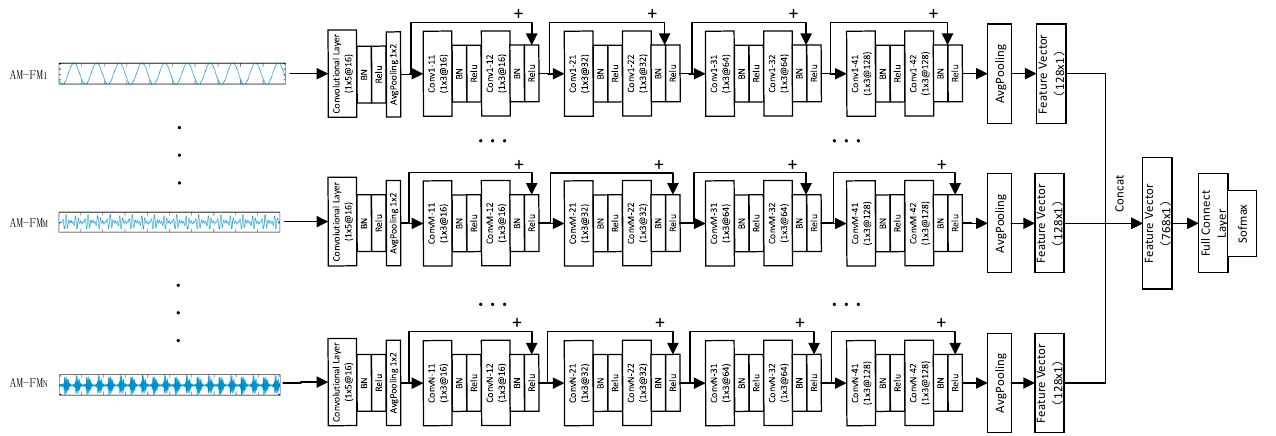
Figure 5. Structure of the multi-input ResNet.